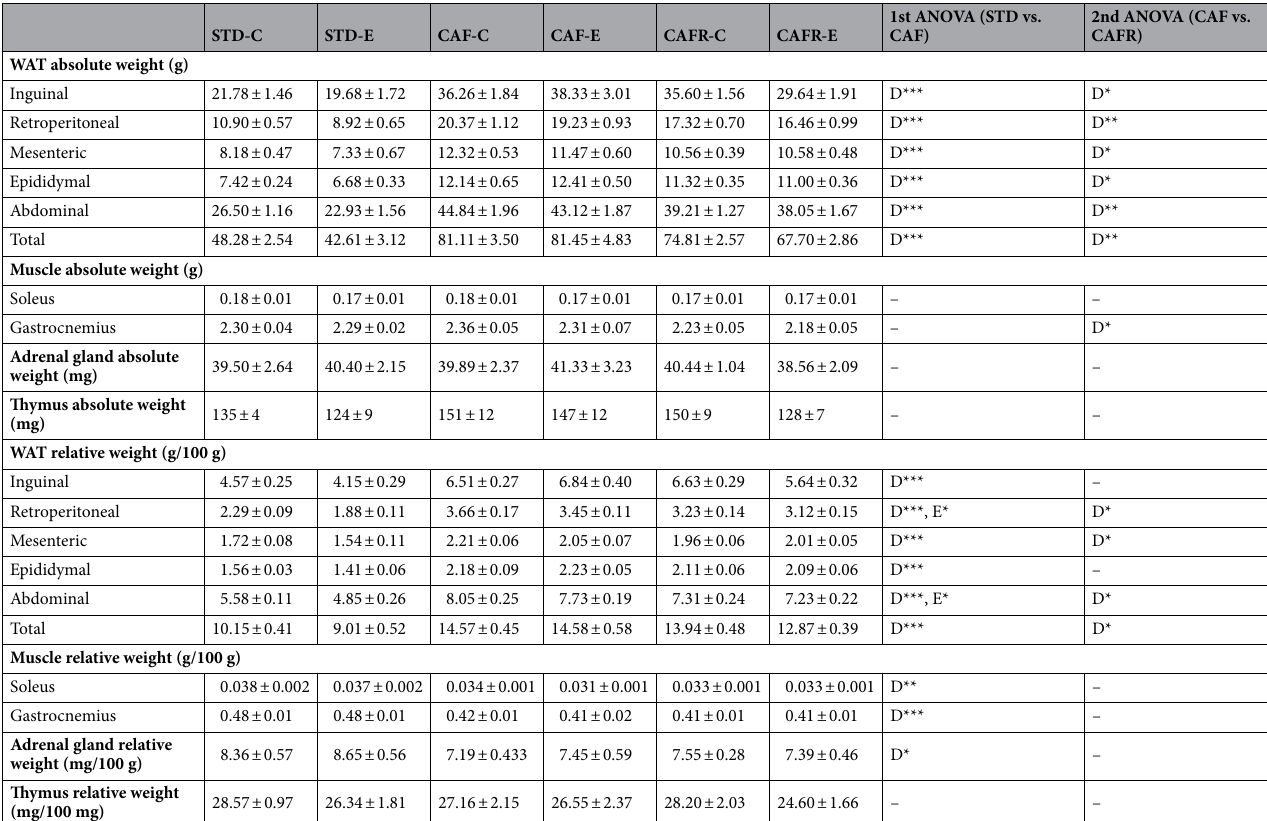
Table 1. Effects of dietary interventions and exercise on the absolute (g) and relative weight (g/100 g) of white adipose depots, skeletal muscle, adrenal gland and thymus at the end of the experiment. The two last right columns indicate the significant ANOVA results for analyzed factors ( D Diet; E Exercise; DxE Diet*Exercise interaction; * p < 0.05; ** p < 0.01; *** p < 0.001). Data are mean ± SEM. Abdominal WAT was calculated as the sum of the retroperitoneal, epididymal and mesenteric depots. WAT: White Adipose